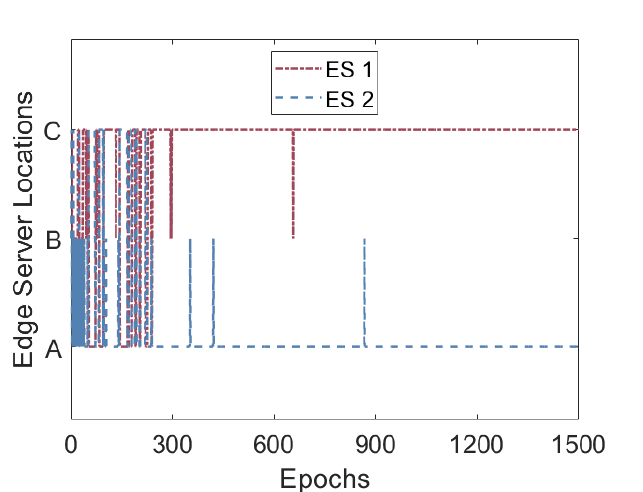
Figure 8. Proposed solution comparison with ground truth for a toy example; where three base stations namely A, B, and C, are placed in a